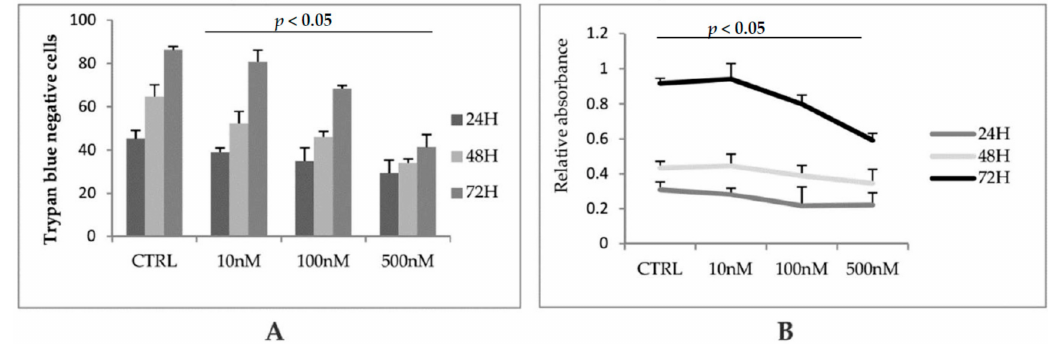
Figure 1. ( A ) Cells viability was measured by counting the unstained cells with Trypan blue. Where indicated cells were treated with 10 nM, 100 nM, and 500 nM of CHIR99021 for 24, 48, and 72 h. ( B ) The same samples were analyzed by 3-(4,5-dimethylthiazol-2-yl)-2,5-diphenyltetrazolium bromide (MTT) assay. The graph shows the relative absorbance read at 570